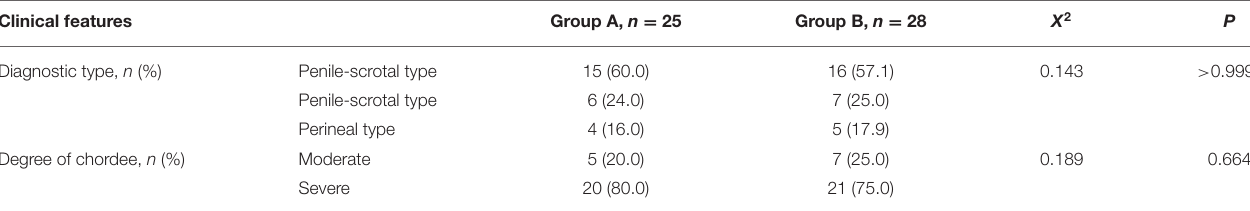
TABLE 2 | Comparison of the clinical diagnostic type and degree of chordee between the two groups. Clinical features